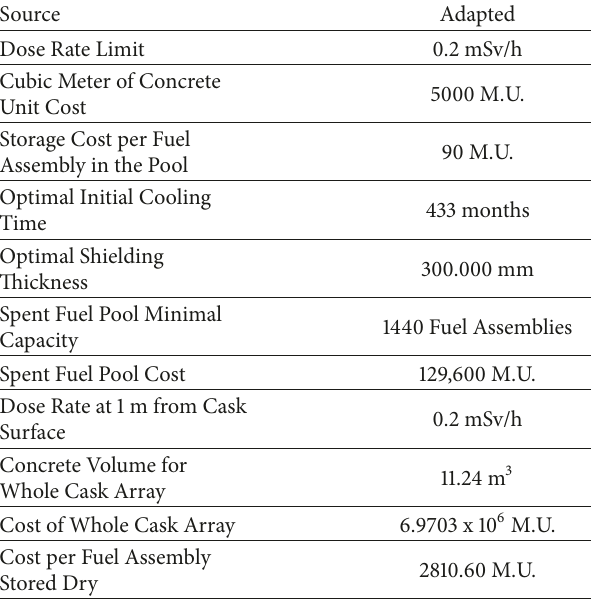
Table 8: Optimal result data for a given set of example parameters with 0.2 mSv/h as the dose rate limit.